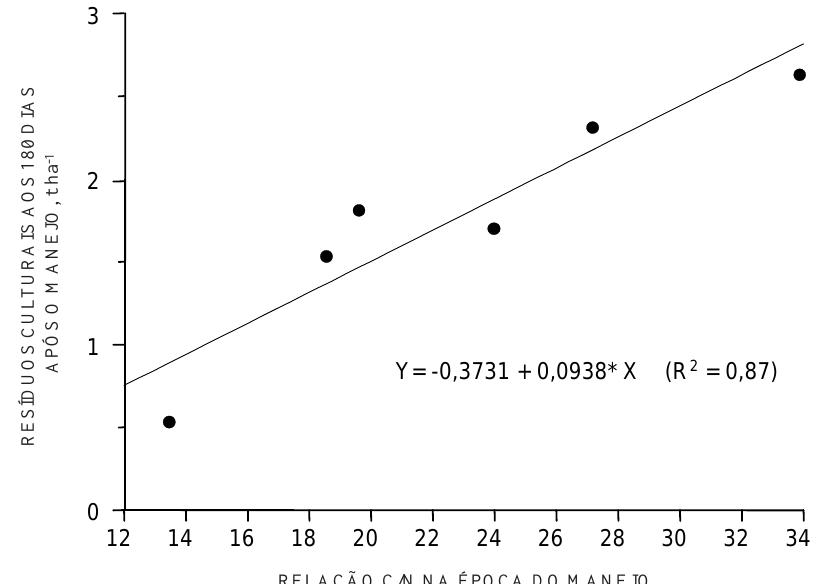
Figura 2. Relação entre a quantidade de resíduos culturais remanescentes da aveia e ervilhaca 180 dias após o manejo e a relação C/N das espécies na época do